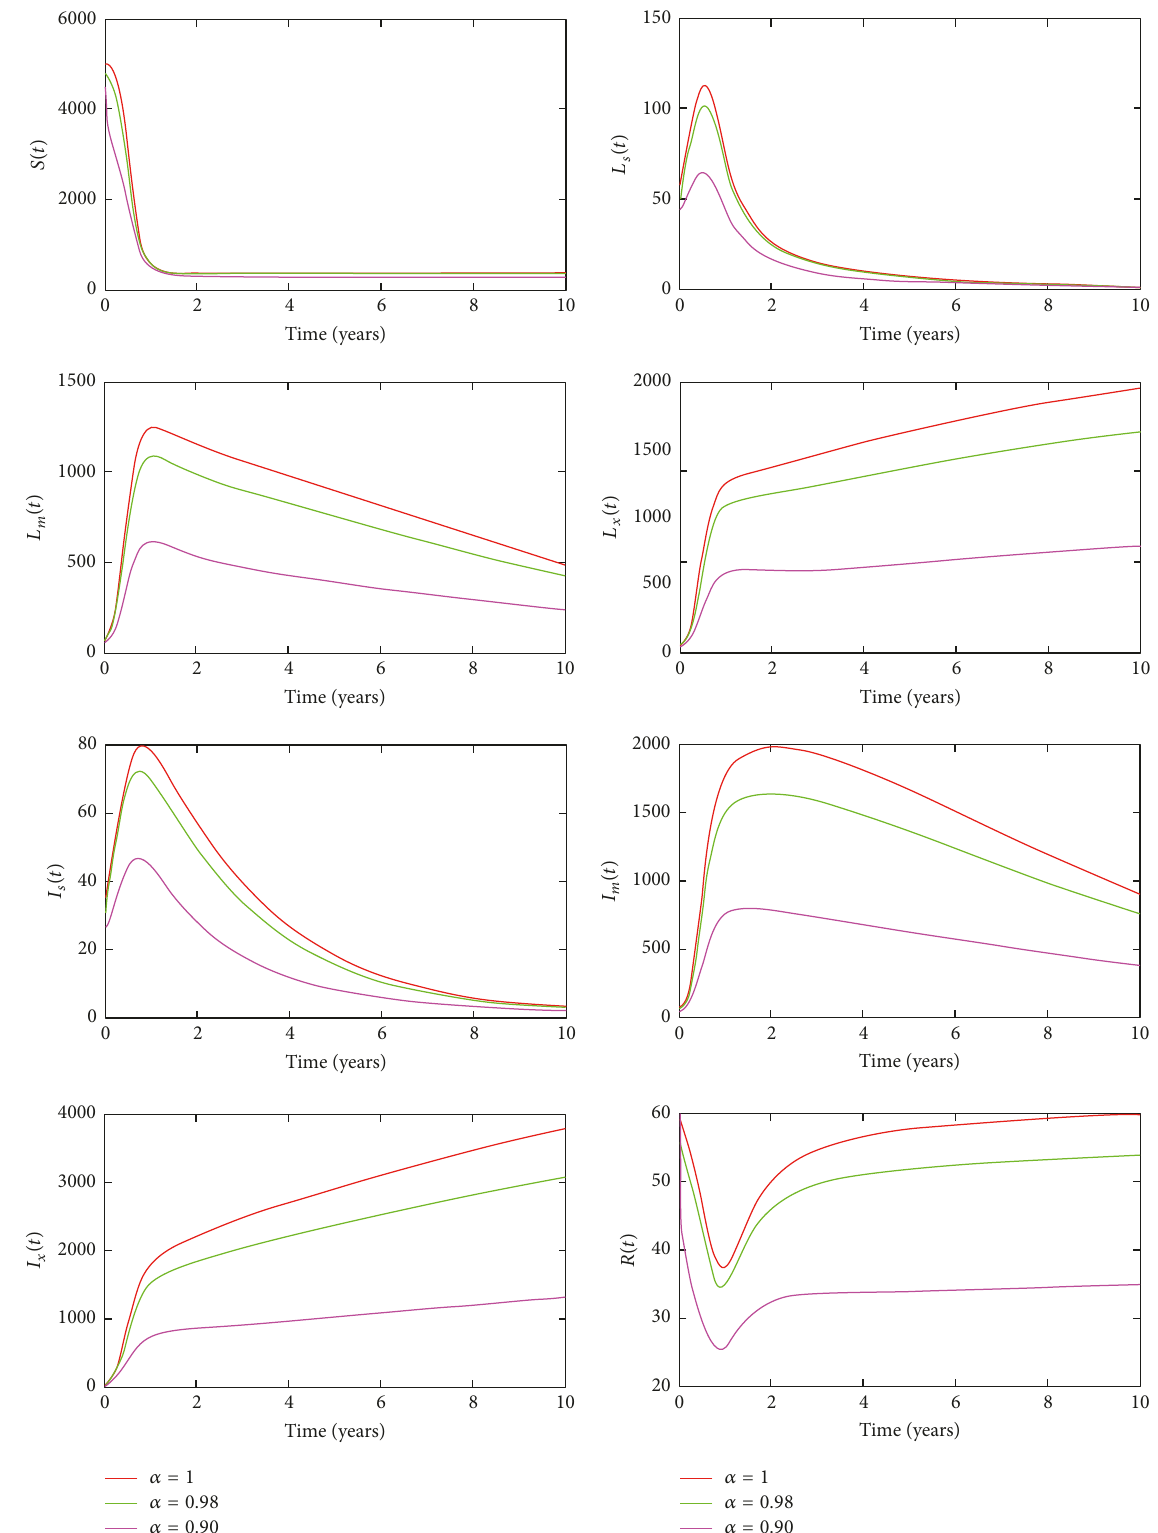
Figure 11: The approximate solutions with 𝜏 = 0.4 and different 𝛼 using